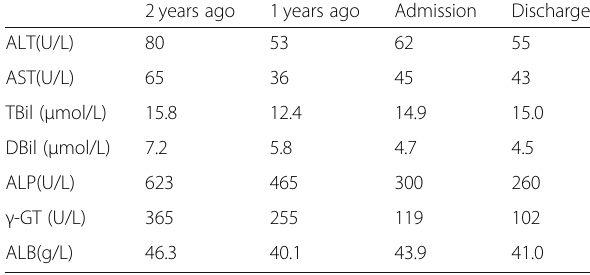
Table 1 Liver function throughout the course of the